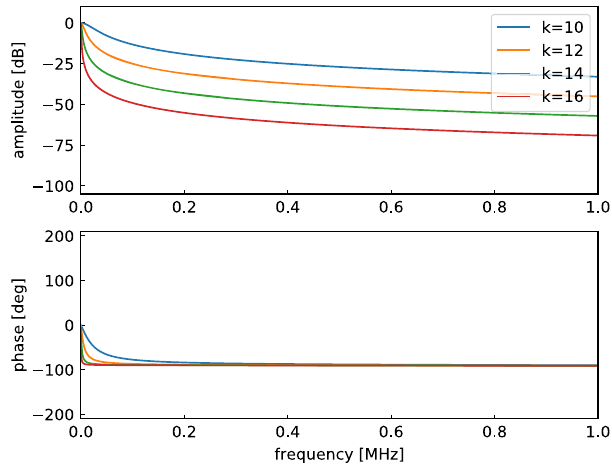
FIG. 12. Amplitude and phase responses of the leaky integrator for k ¼ 10 , 12, 14,